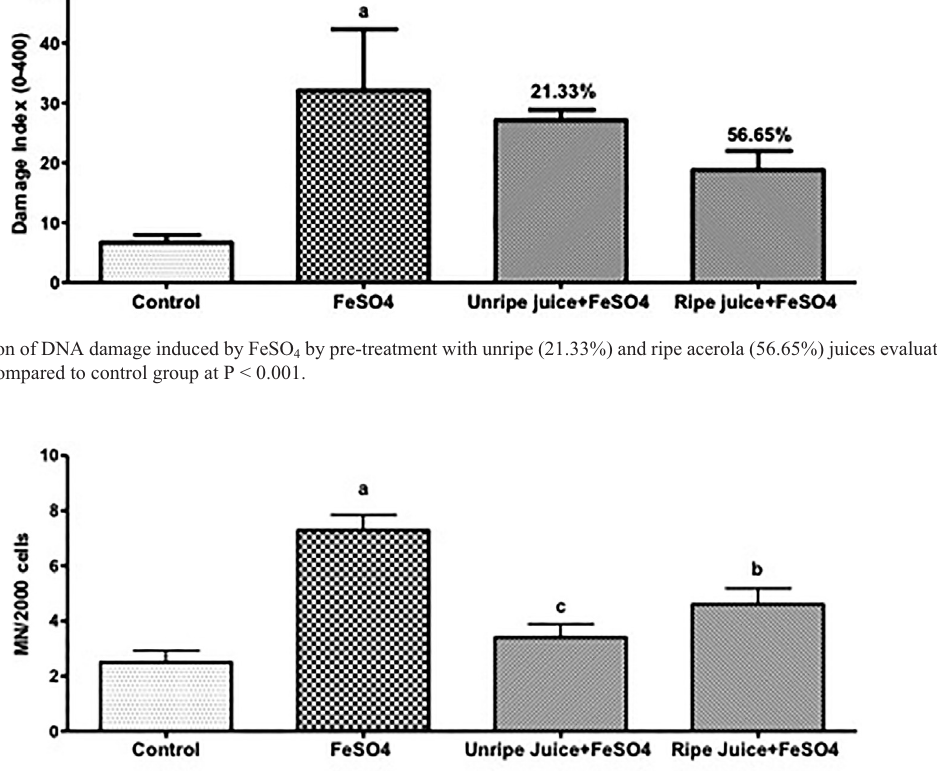
Figure 2 - Antimutagenic activity of acerola unripe and ripe juices evaluated by Micronucleus test. a Significant compared to control group at P < 0.001; b significant compared to FeSO c P < 0.001; Kruskall-Wallis (Dunn). 4 group at P < 0.01, and